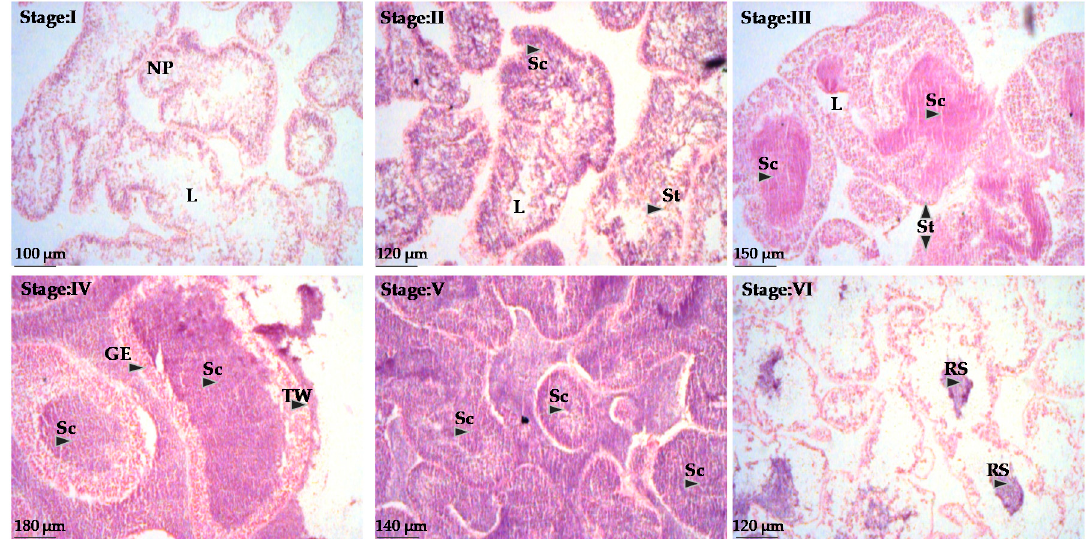
Figure 7. Histology of testes (right) of Sphaerechinus granularis . NP = nutritive phagocytes, L = lumen, Sc = spermatocytes, St = spermatids, GE = germinal epithethelium, TW = teste wall, RS = relict spermatozoa (stages are defined as in Figure 6).